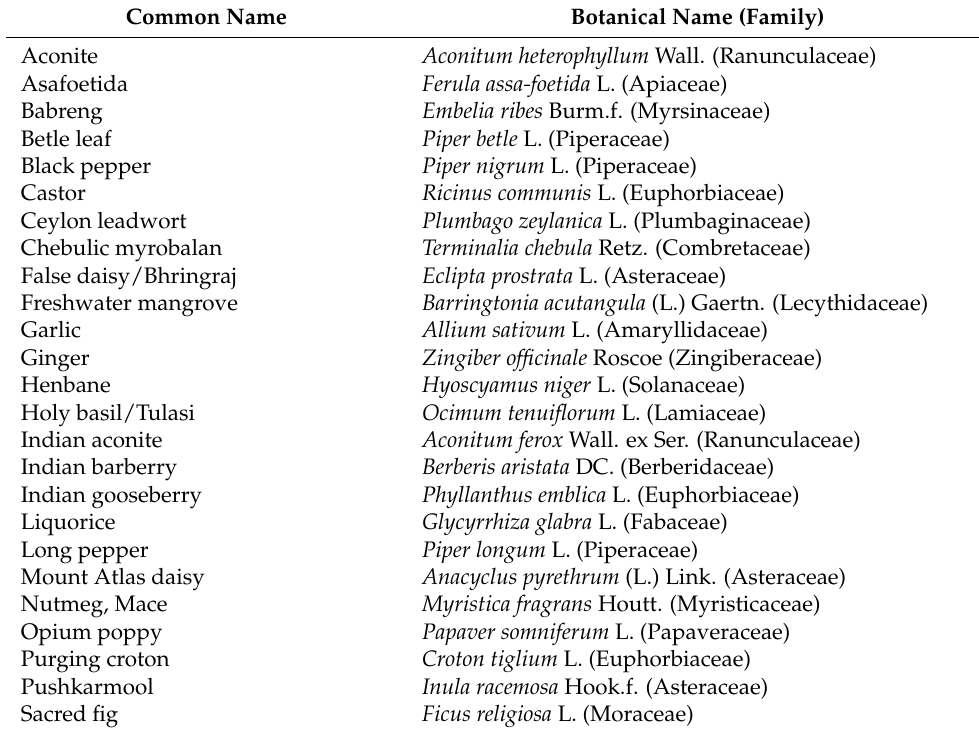
Table 3. Plant species used in Nagachya Golya and Vyadhiharak Vatika